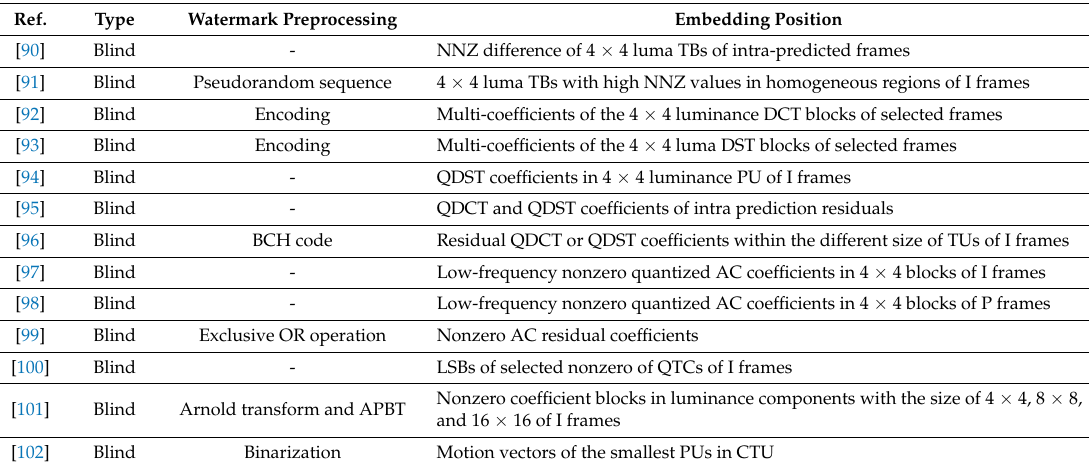
Table 11. Summary comparison of several H.265-based watermarking algorithms.